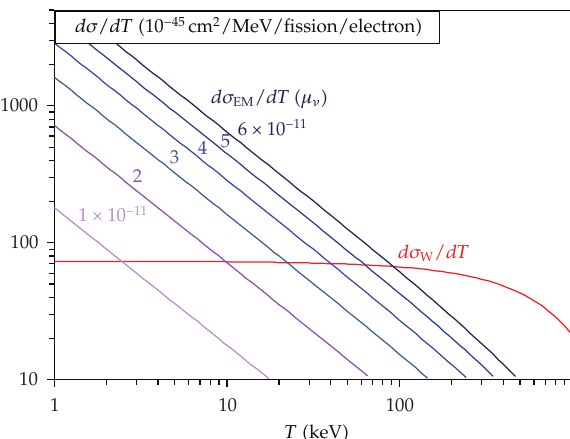
Figure 2: Standard Model weak (cid:3) W (cid:4) and magnetic moment electromagnetic (cid:3) EM (cid:4) contributions to the cross section for several values of the neutrino magnetic moment (cid:5) 43 (cid:6)